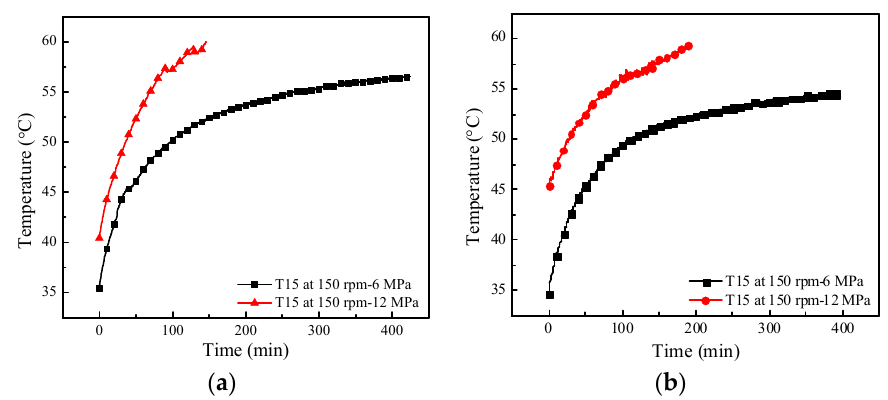
Figure 8. Comparison of temperature at the same rotational speed and different loads. ( a ) S220; ( b ) M220.